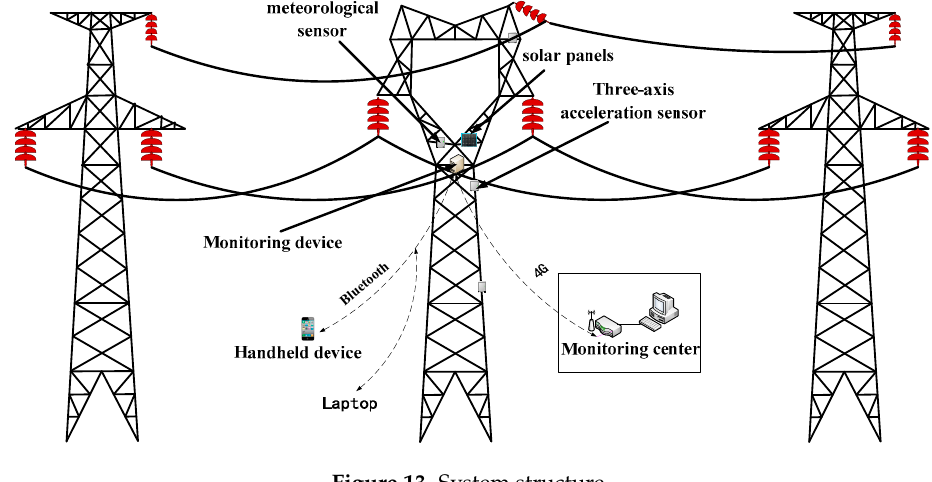
Figure 13. System Figure 13. System structure.